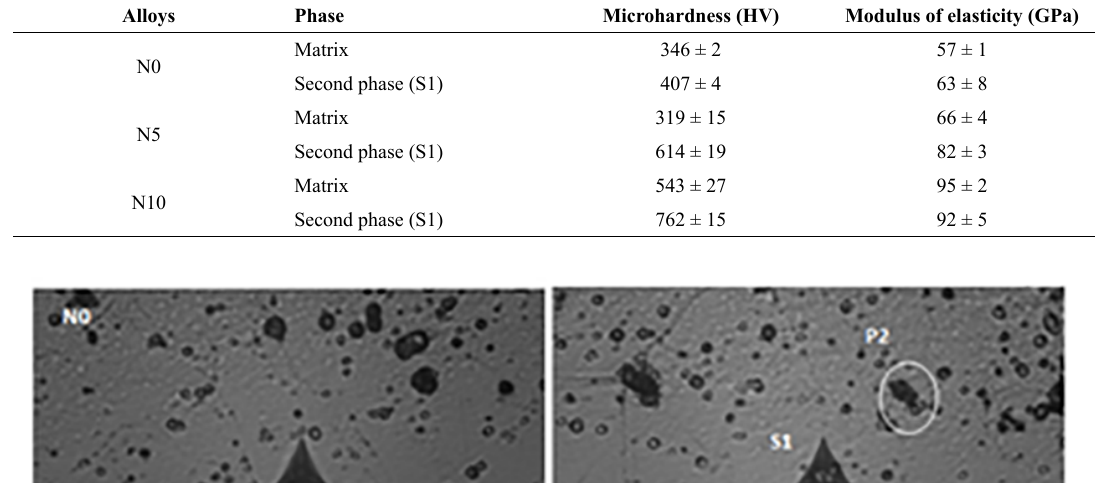
Table 4. Microhardness and modulus of elasticity of the alloys (Ti